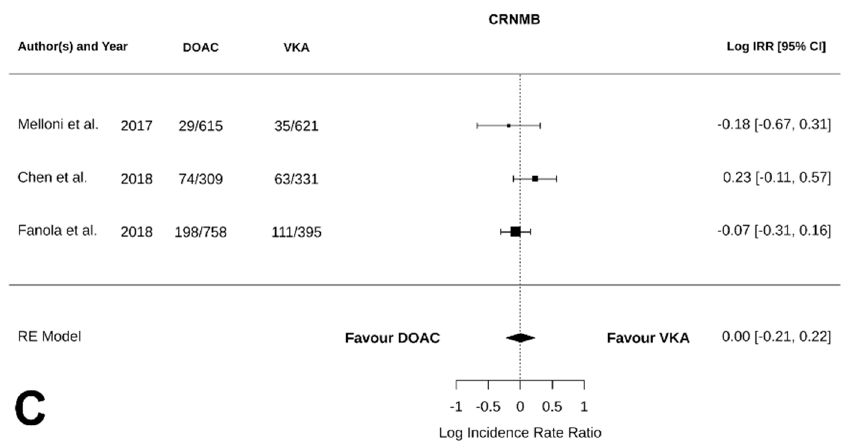
Figure 4. Forest plot of the IRR for safety outcomes in VKAs versus DOACs. ( A ). Hemorrhagic stroke. ( B ). Major bleedings. ( C ). Clinically relevant non-major bleeding. * rivaroxaban, ** dabigatran, *** apixaban [19,27,29–32].